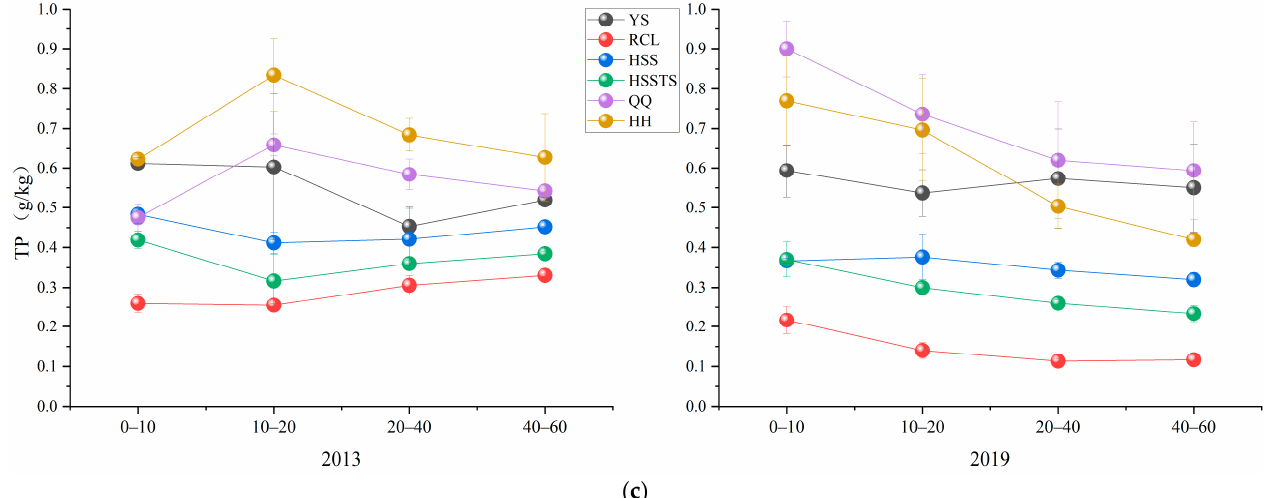
Figure 6. Total available nutrient content of different forest communities at four soil depths in both 2013 and 2019; ( a ) soil total potassium, ( b ) soil total nitrogen, ( c ) soil total phosphorus.